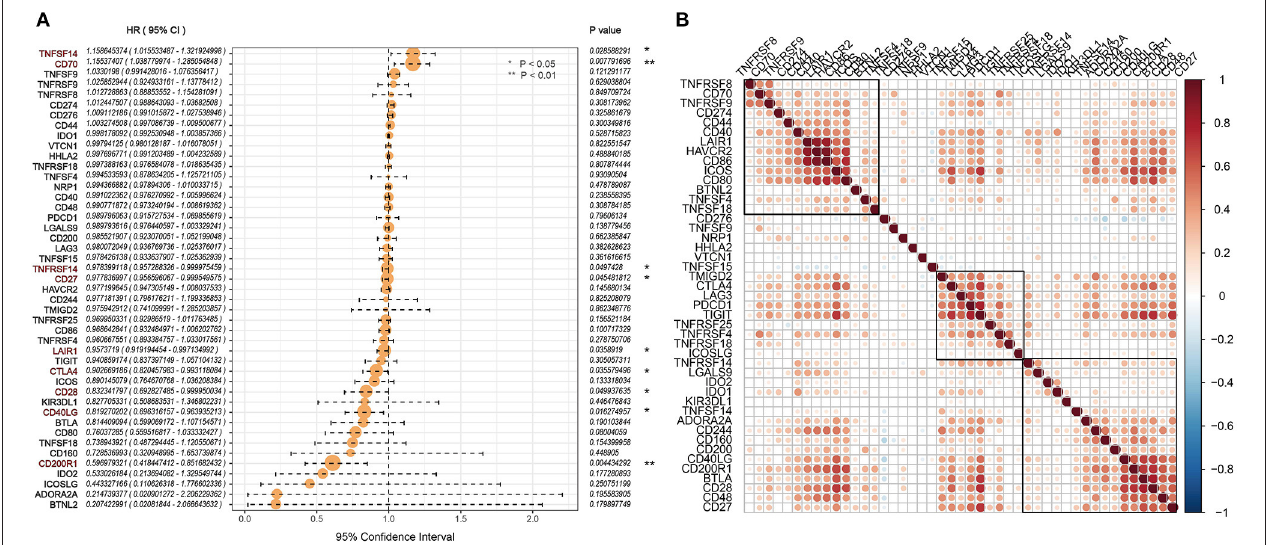
FIGURE 2 | (A) Relationship between ICGs expression and prognosis in forest plot. Abscissa represents 95% confidence interval, ordinate (left) represents gene, and the vertical line in the middle of P -value represents the invalid line. When the horizontal line of 95% confidence interval of a gene crosses with the invalid line, it can be considered that there is no statistical correlation between gene expression and patient survival. If the horizontal line falls to the left of the invalid line, the gene can indicate a higher likelihood of success for patient prognosis. If the horizontal line falls to the right of the invalid line, it can be considered as a risk factor for the patient survival. (B) Correlation heatmap of ICGs expression levels. Only the gene pairs with significant correlation test are shown: the blank indicates zero significance of correlation test, blue represents negative correlation, and red represents positive correlation. * P < 0.05, ** P <